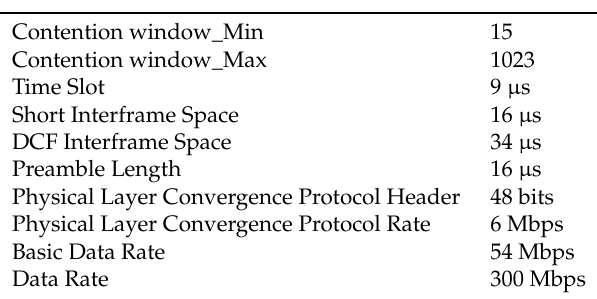
Table 2. NS-2 Parameters.